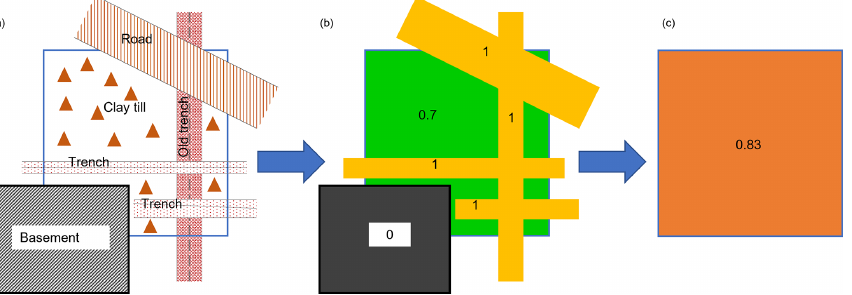
Figure 3. Workflow for setting the value of a voxel. (a) Voxel with clay till and anthropogenic subsurface infrastructure. (b) The correspond- ing sand/clay fractions. (c) The resulting representative sand/clay fraction for the voxel, which is based on average according to volume.